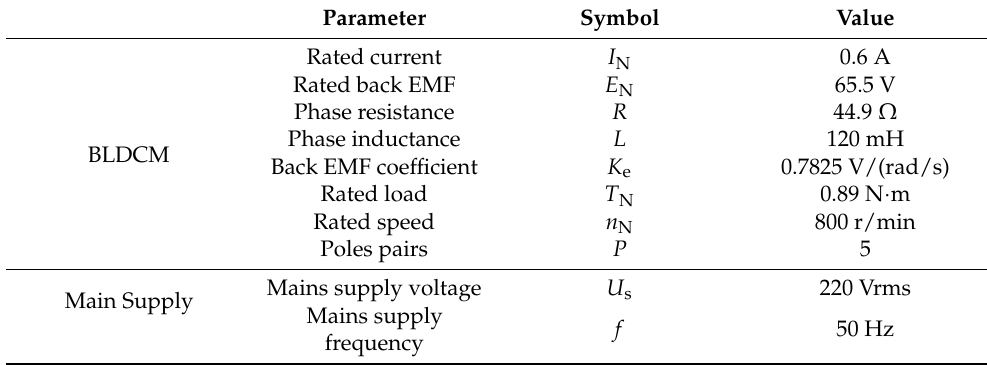
Table 2. The BLDCM system parameters and AC power parameters of the experimental